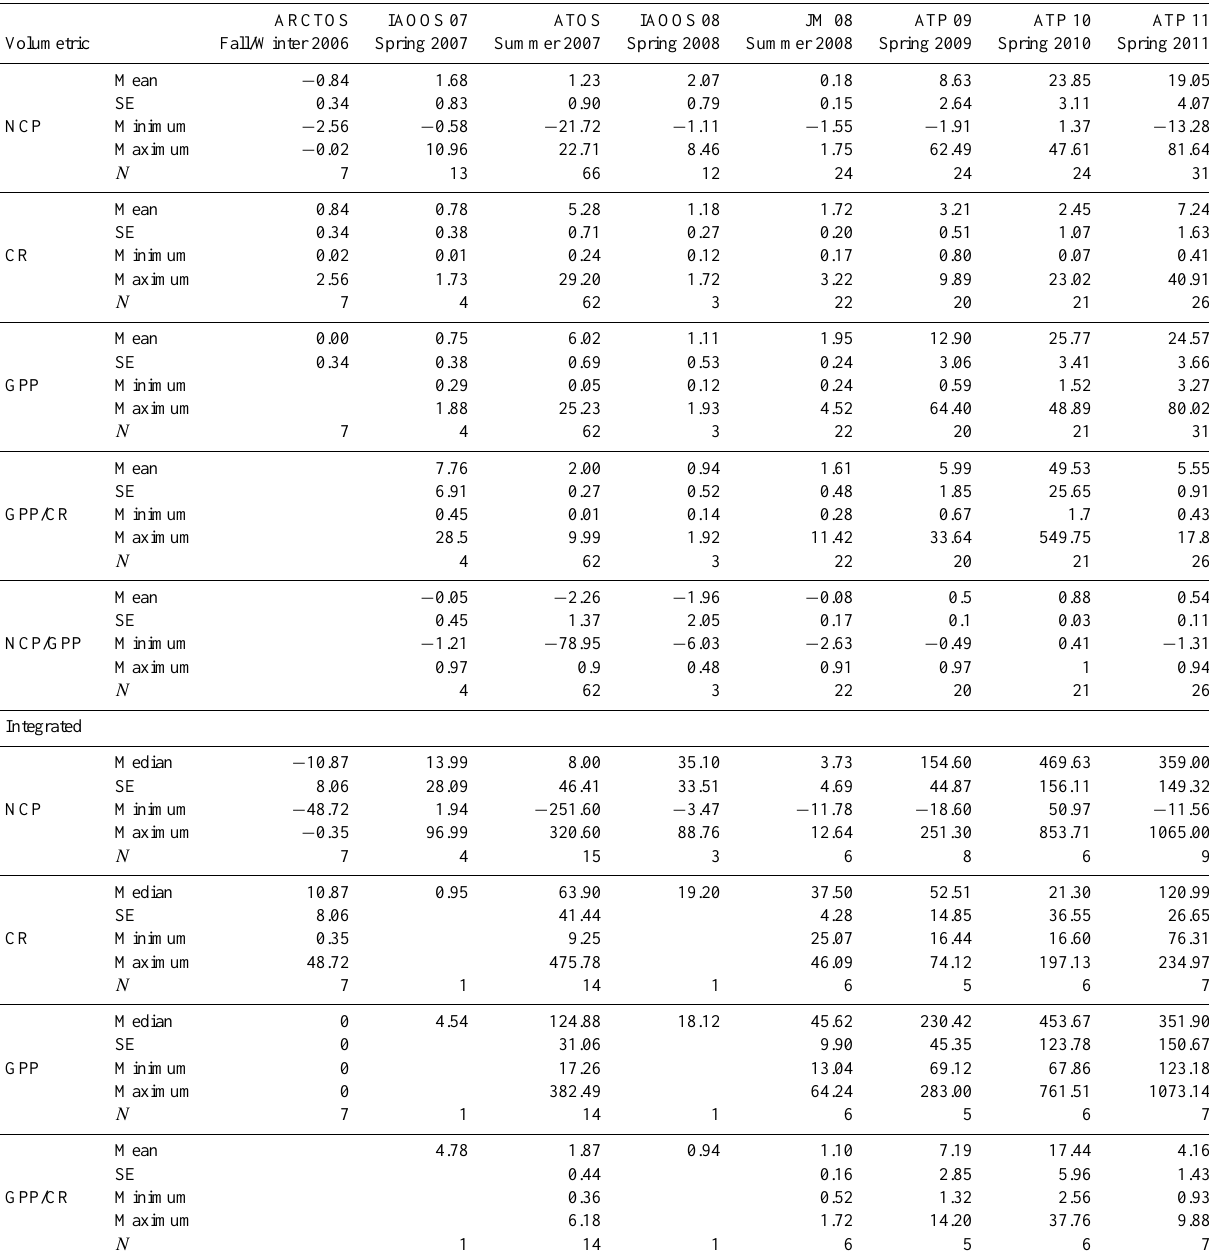
Table 2. Mean, standard error, range and number of observations of volumetric (mmolO 2 m − 3 d − 1 ) and median, standard error, range and number of observations ( N ) of integrated metabolic rates (mmolO 2 m − 2 d − 1